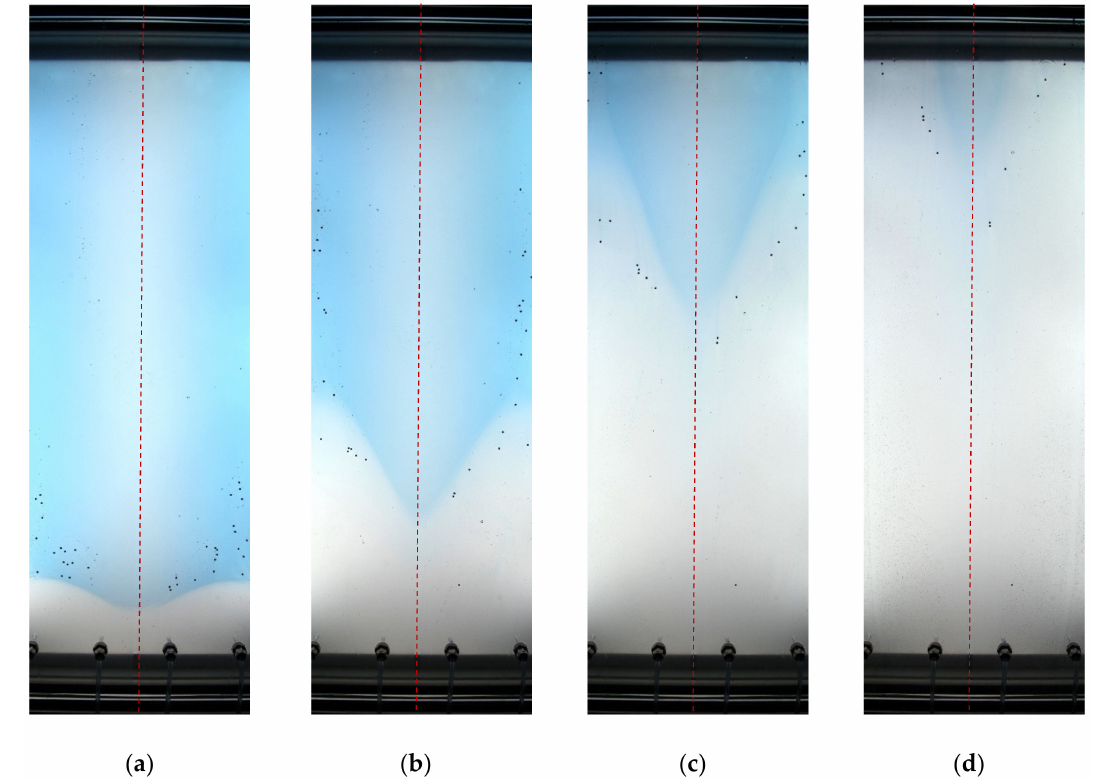
Figure 12. Snapshots of displacement flow in test no. 7. ( a ) t = 0 s; ( b ) t = 4 s; ( c ) t = 9 s; ( d ) t = 13 s.